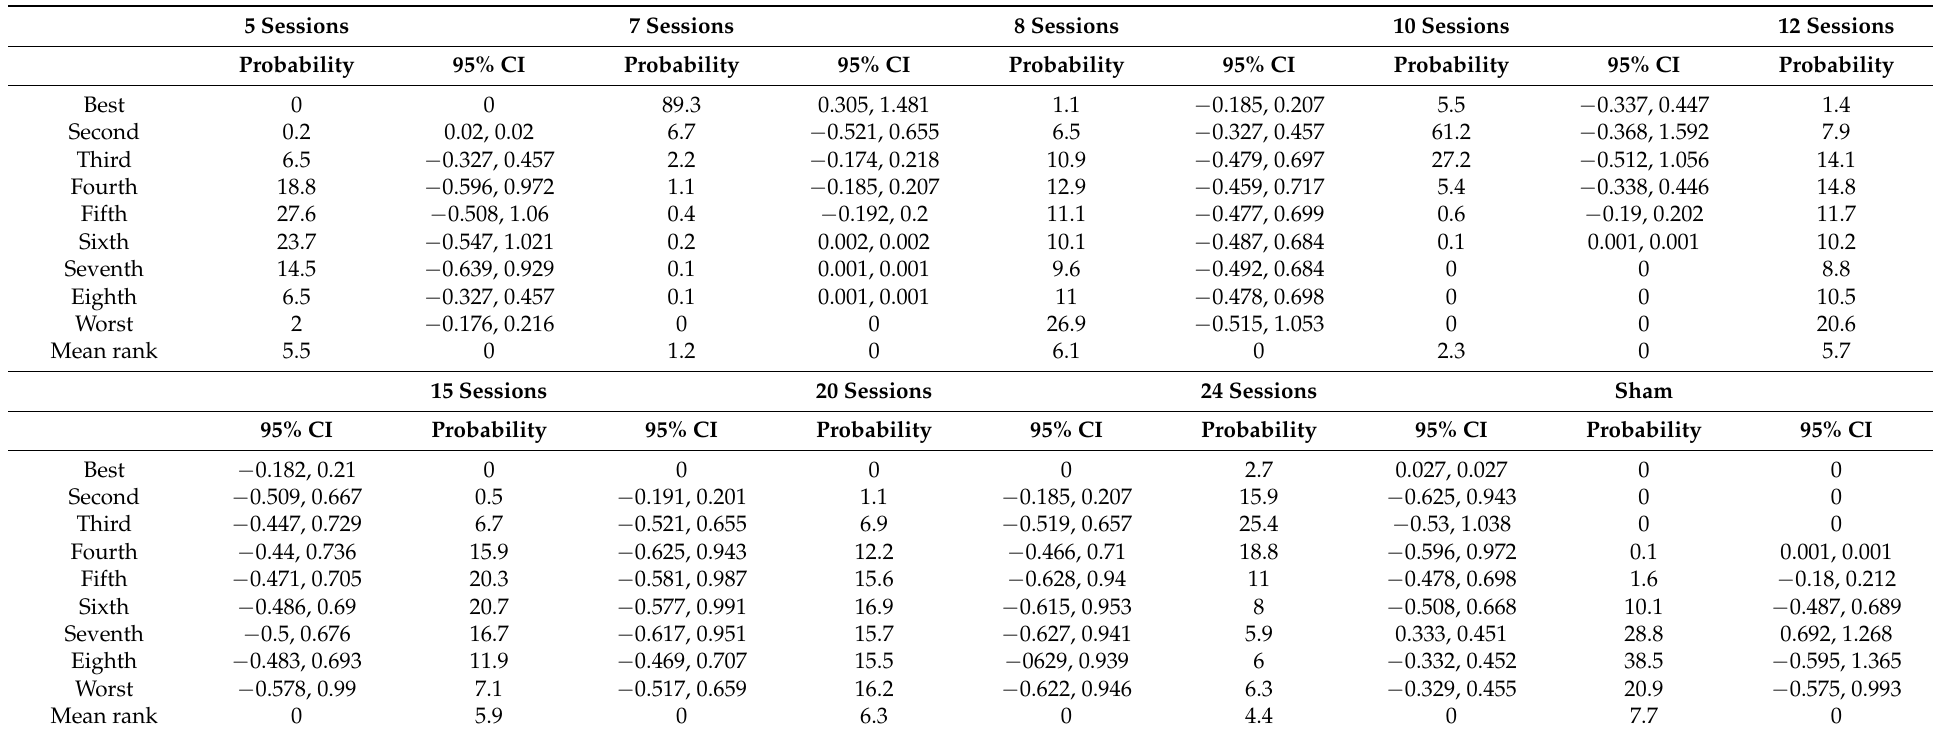
Table 3. Results: network meta-analysis number of